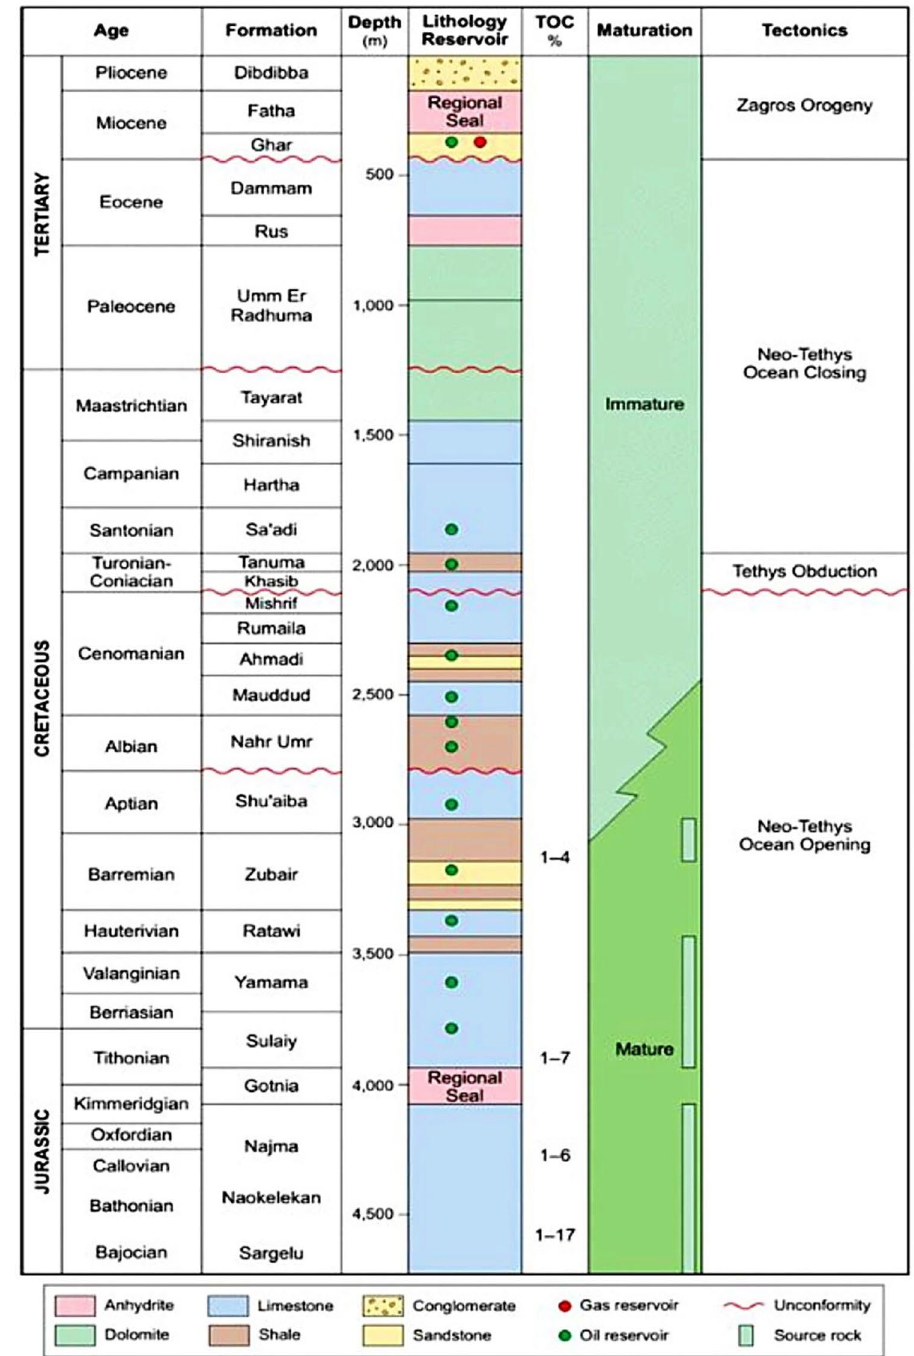
Fig. 2 A generalized lithostrati- graphic column of the Meso- potamian Basin in south Iraq (Al-Ameri et al.